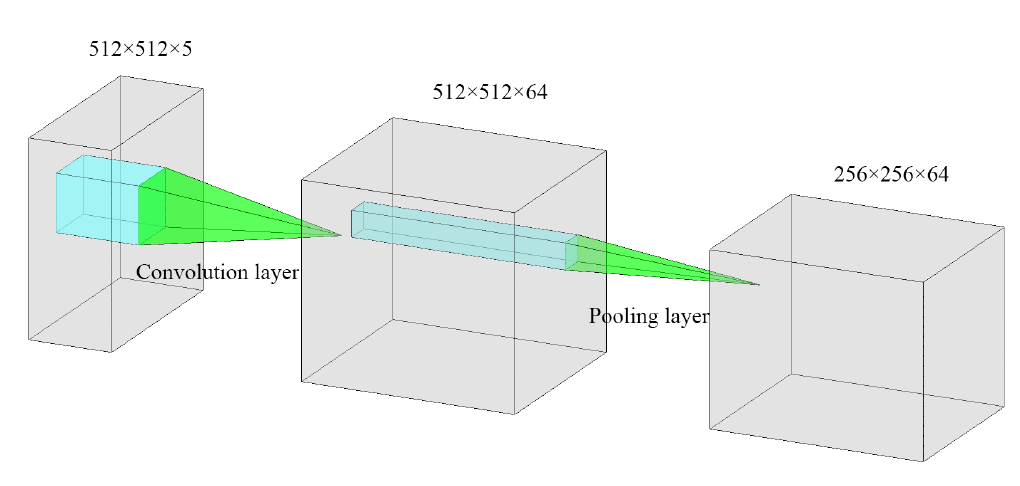
Figure 13. The schematic diagram of the convolution and pooling layers.